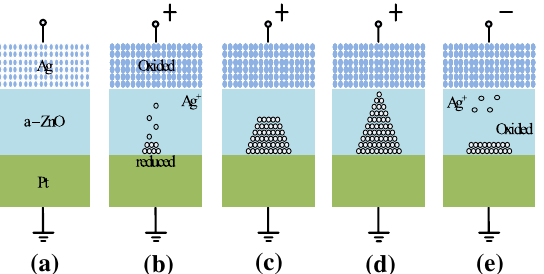
Fig. 7 Schematic of the switching mechanism of conductive bridge RRAM: a Initial state. b , c Oxidation of Ag and migration of Ag + cations towards cathode and their reduction. d Accumulation of Ag atoms and Pt electrode leads to growth of highly conductive filament. e Fila- ment dissolution takes place on applying voltage of opposite polarity [72]